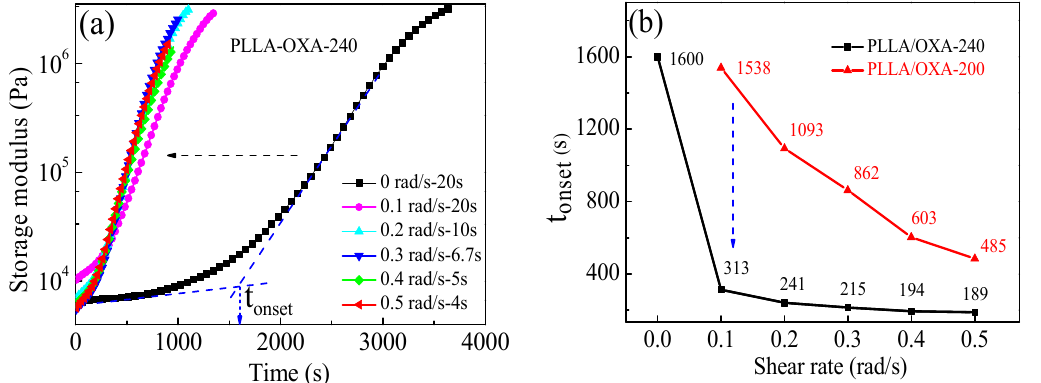
Figure 5. ( a ) Storage modulus of the PLLA/OXA-240 samples as a function of the crystallization time at 155 °C and the shear rate; ( b ) the t onset values of the PLLA/OXA samples as a function of the shear